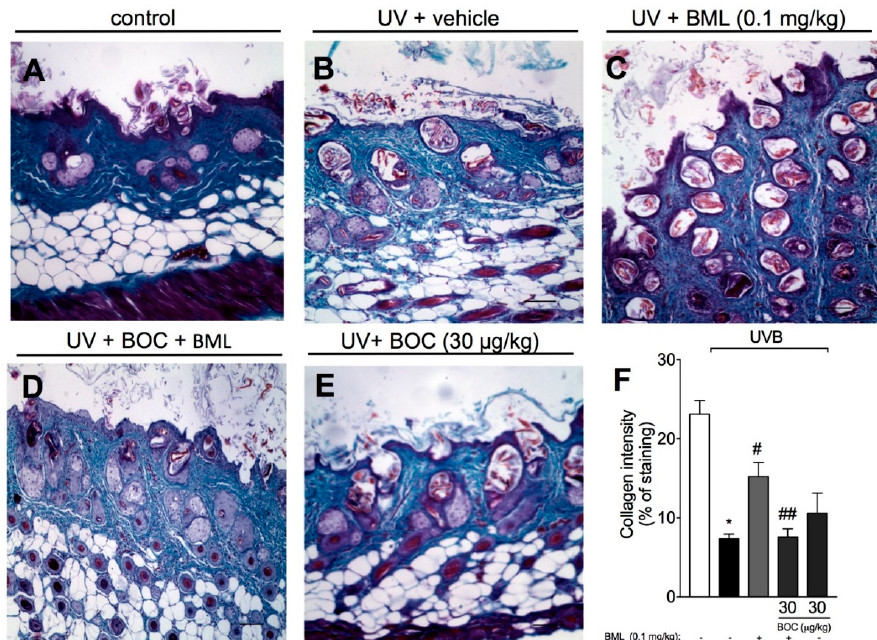
Figure 5. BML-111 prevents UVB irradiation-induced collagen degradation. Degradation of collagen was determined in samples dissected 12 h after the radiation and stained with Masson’s trichrome.